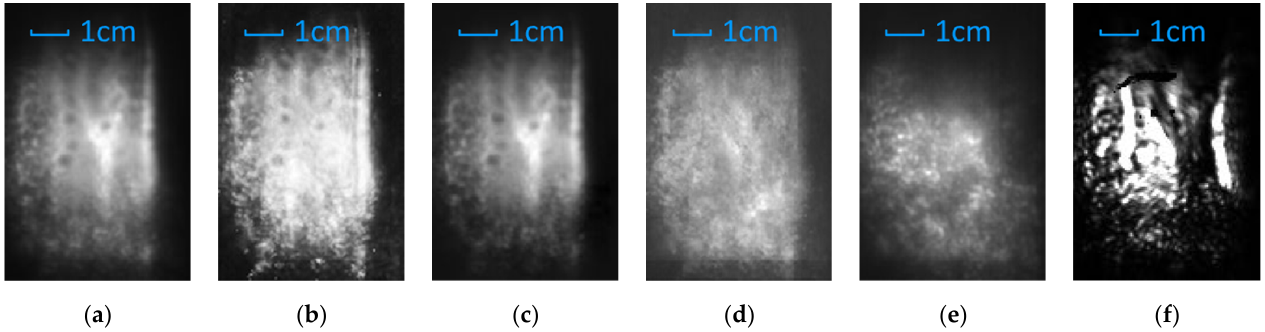
Figure 10. The reconstruction results of the “practical” marine antifoul coating sample with different methods. ( a ) The conventional LFI-SA method. ( b ) Coating layer with the Tao’s method based on k-means clustering. ( c ) Coating layer with the AIF method. ( d ) Base layer with the Tao’s method. ( e ) Base layer with the AIF method. ( f ) Imaging result with single camera, as contrast.